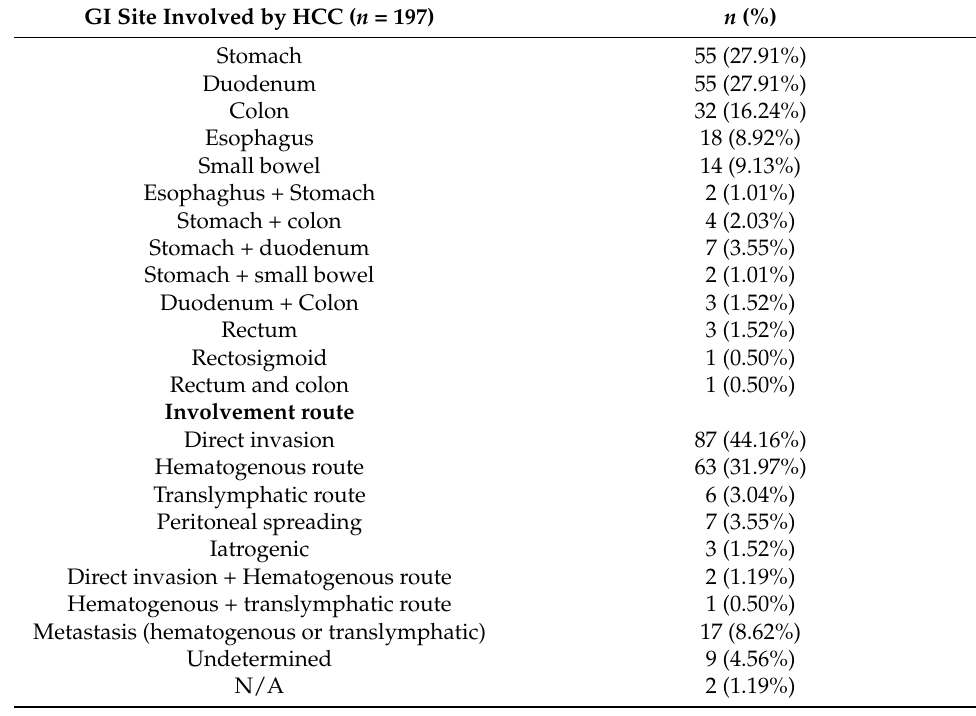
Table 6. Involved GI site and involvement route.